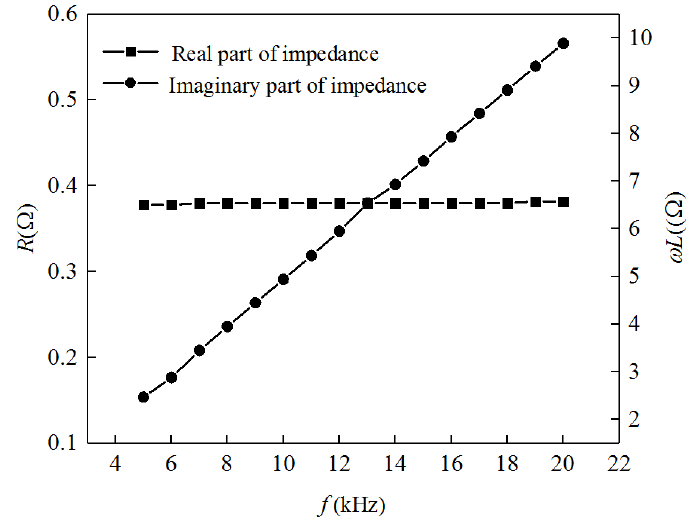
Figure 12. Impedance of coil as a function of frequency.